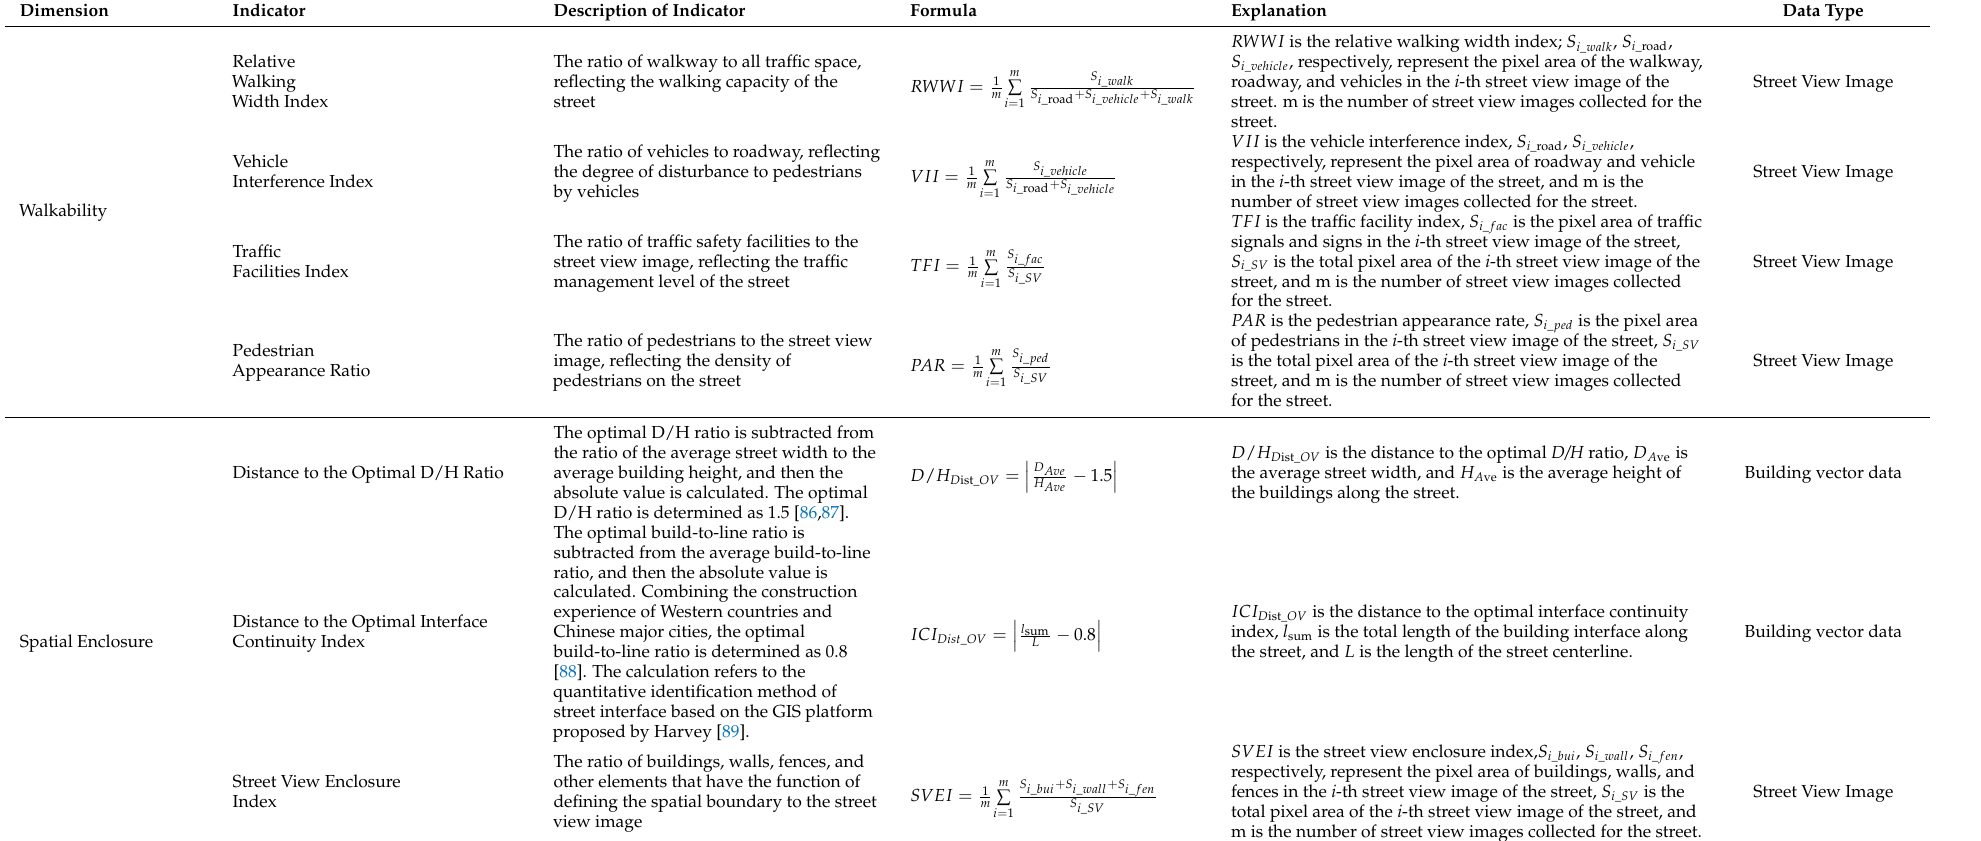
Table 2. The description and calculation method of street safety assessment